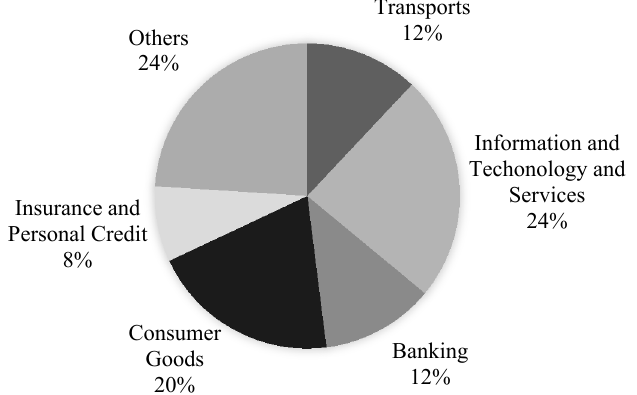
Figure 2. Sample description: industry distribution.